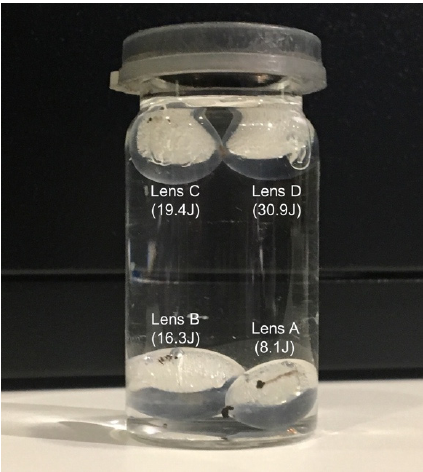
of the lens, thereby allowing for it to float in the saline. Laser irradiation energy amount listed in